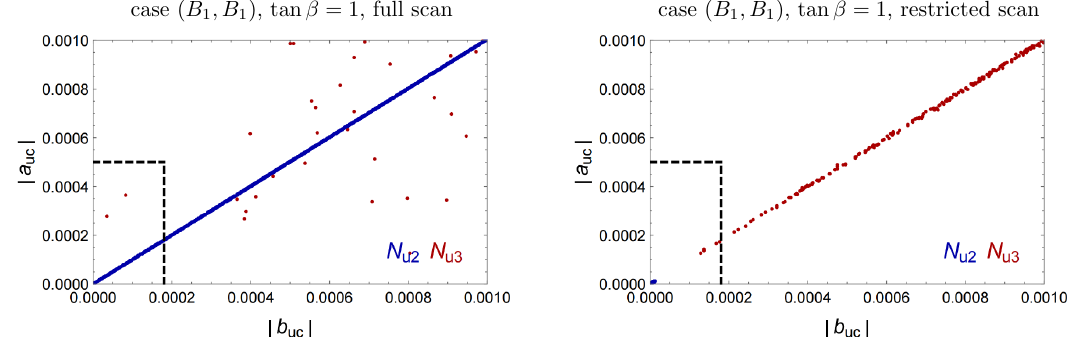
Figure 3 . The impact of D -meson oscillations. Shown are the values of | a uc | , | b uc | in a full scan (left) and a restricted scan with θ = π/ 100 (right). The dashed box shows the limits eq. (3.3d). max